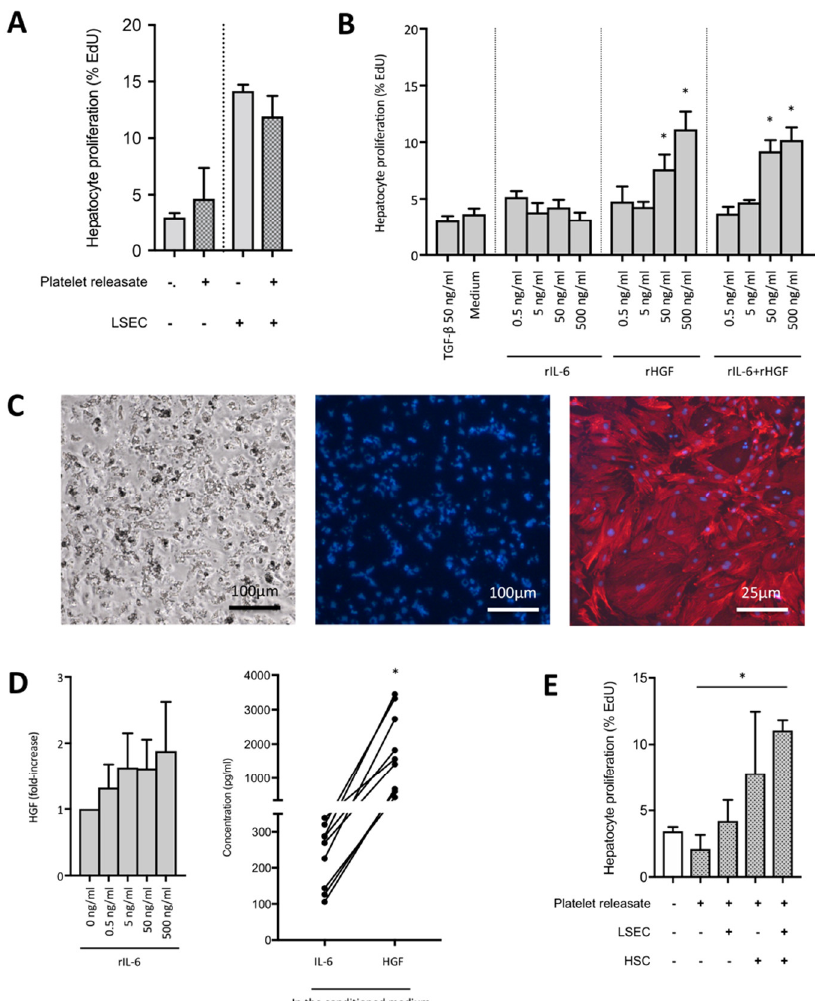
Figure 2. IL-6 released from LSECs upon the action of platelets stimulates HGF secretion from HSCs and leads to hepatocyte proliferation. ( A ) Hepatocyte proliferation according to EdU incorporation after 24 h in culture, in the presence or not of platelets and / or LSECs. N = 3. ( B ) Hepatocyte proliferation according to EdU incorporation, in the presence or not of increasing concentrations of recombinant IL-6 and / or HGF. N = 6, * p < 0.05. ( C ) Left: Autofluorescence of freshly isolated HSCs after excitation with an ultraviolet source. Middle: Oil-Red-O staining of HSCs cultivated 24 h. Magnifications 200 × and 400 × . Right: HSCs were stained with antibodies against α -SMA (red) after 7 days of culture following their activation with TGF- β 1. Nuclei are stained with Hoechst (blue). ( D ) Left panel: HGF secretion at 24 h of culture of HSCs in the presence of increasing concentrations of recombinant IL-6. N = 3. Right panel: HGF secretion at 24 h of culture of HSCs exposed to the conditioned medium of LSECs cultured for 24 h with the releasate of activated platelets. Left dots: concentration of IL-6 in the conditioned medium, right dots: concentration of HGF released by HSCs when exposed to the conditioned medium. N = 9, * p < 0.05. ( E ) Hepatocyte proliferation according to EdU incorporation after 24 h in culture, in the presence or not of platelets, LSECs and HSCs or conditioned-medium of LSECs cultured with platelets or of HSCs cultured with the latest. N = 2–3 (depending on experimental